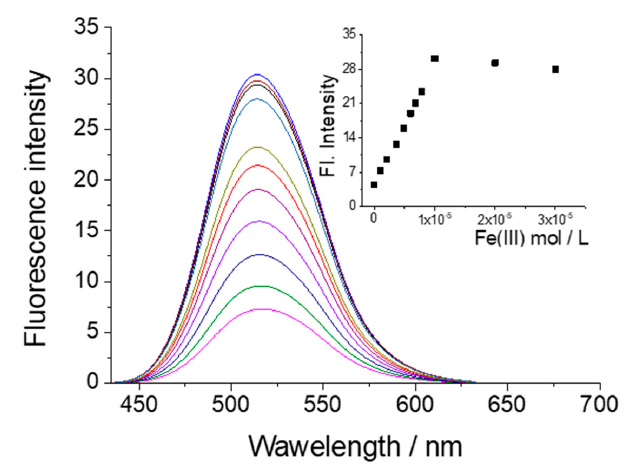
Figure 12. Fluorescence spectra of NI3 (c = 1 × 10 − 5 mol L − 1 ) in acetonitrile solution at presence of Fe(III) ions (c = 0 ÷ 3 × 10 − 5 mol L − 1 ). Inset shows change of the fluorescent intensity depending of the Fe(III) concentrations.